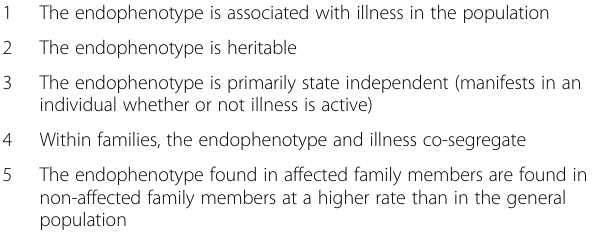
Table 3 The criteria for endophenotypes (adapted from Gottesman et al.